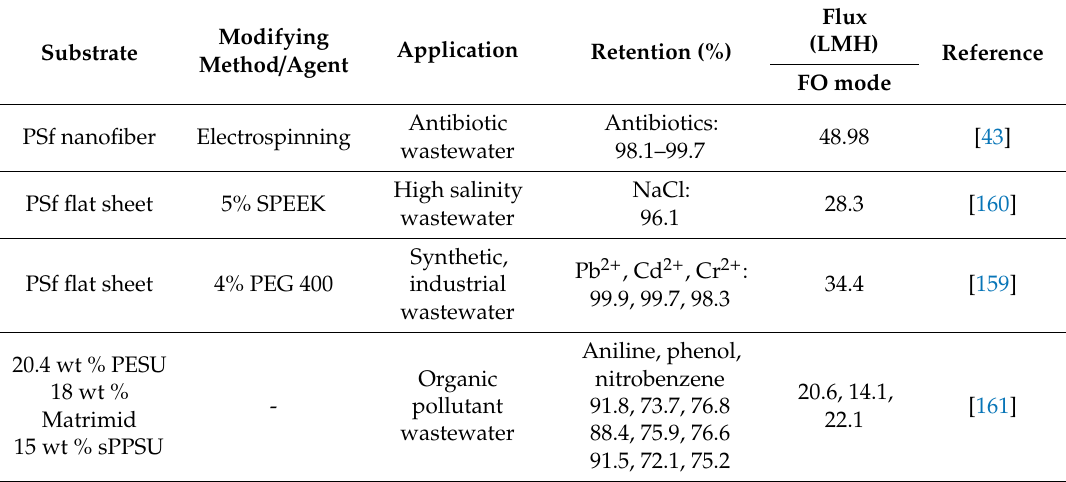
Table 2. Performance and modification comparison of substrate modifications for wastewater